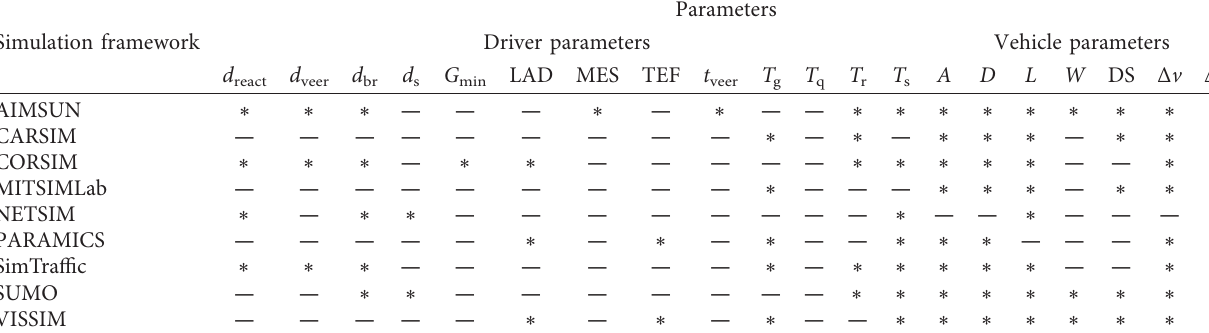
Table 2: Parameters used in various simulation frameworks. Parameters Simulation framework Driver parameters Vehicle